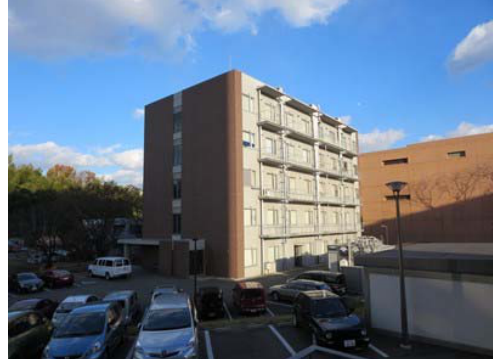
Figure 5. Osaka University US1 Building